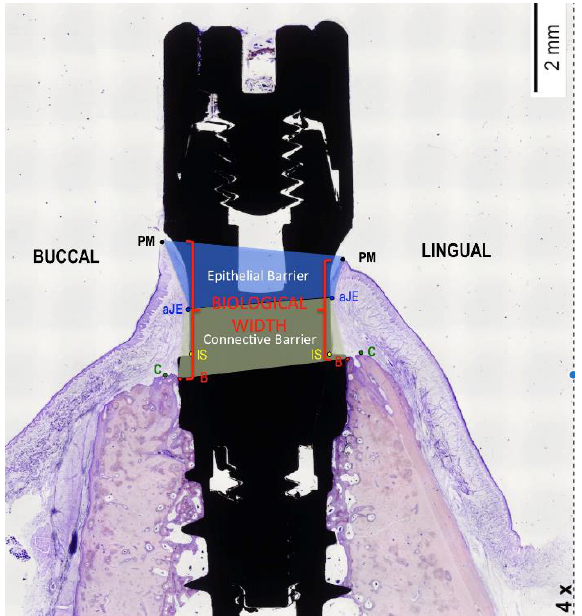
Figure 5. Diagram illustrating the landmarks for histological evaluation. IS—implant shoulder; B—most coronal bone-to-implant contact location; C—top of the alveolar crest; aJE—the apical border of the junctional epithelium; PM—the top of the margin of the peri-implant mucosa.